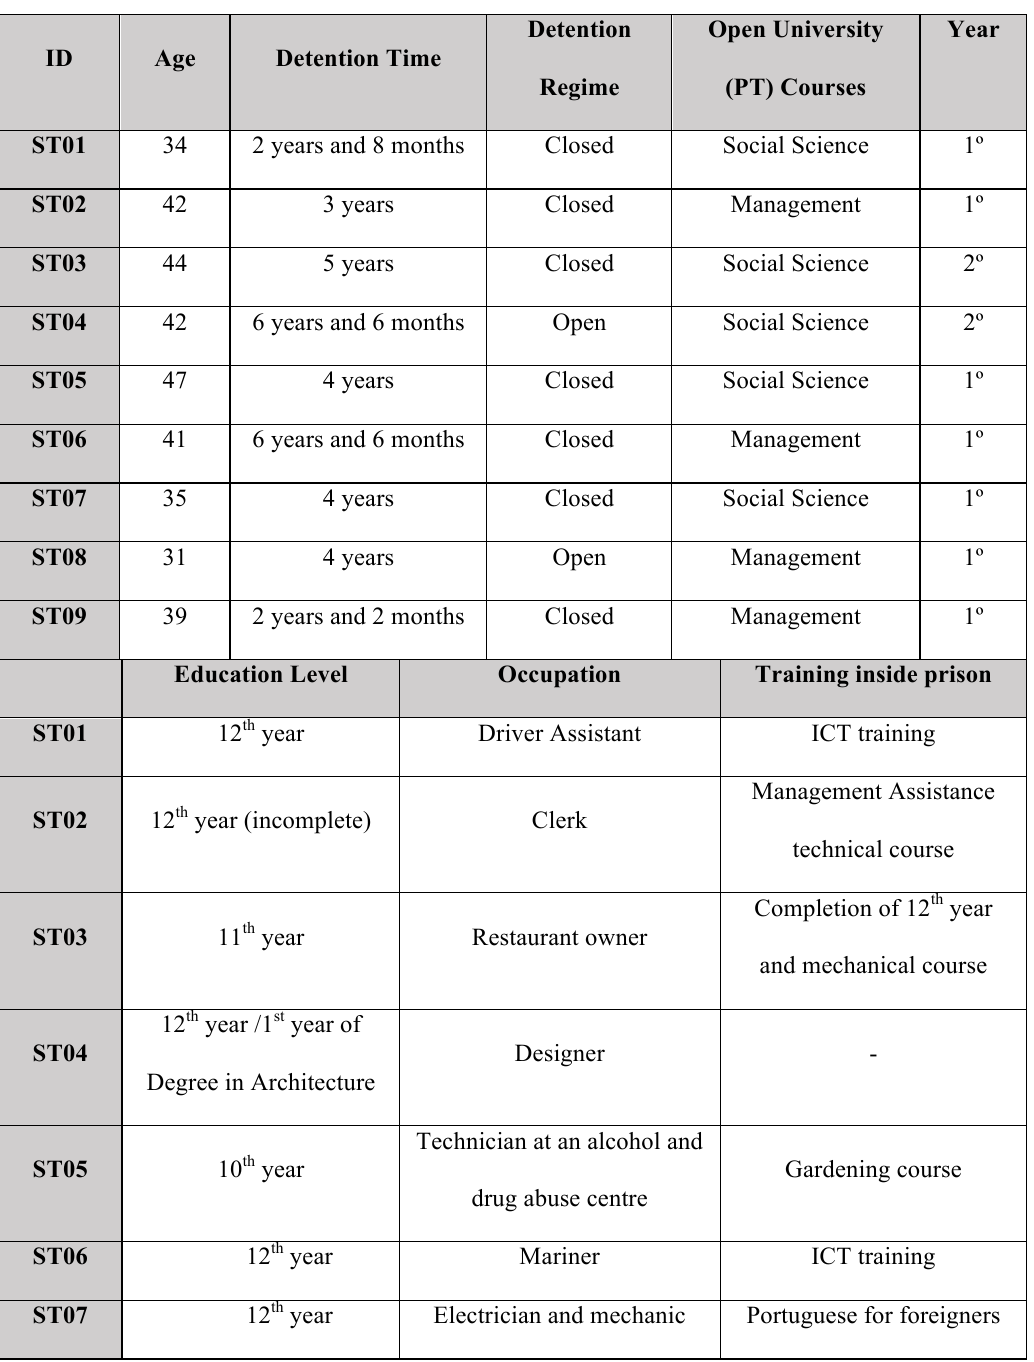
Table 1 . Characteristics of